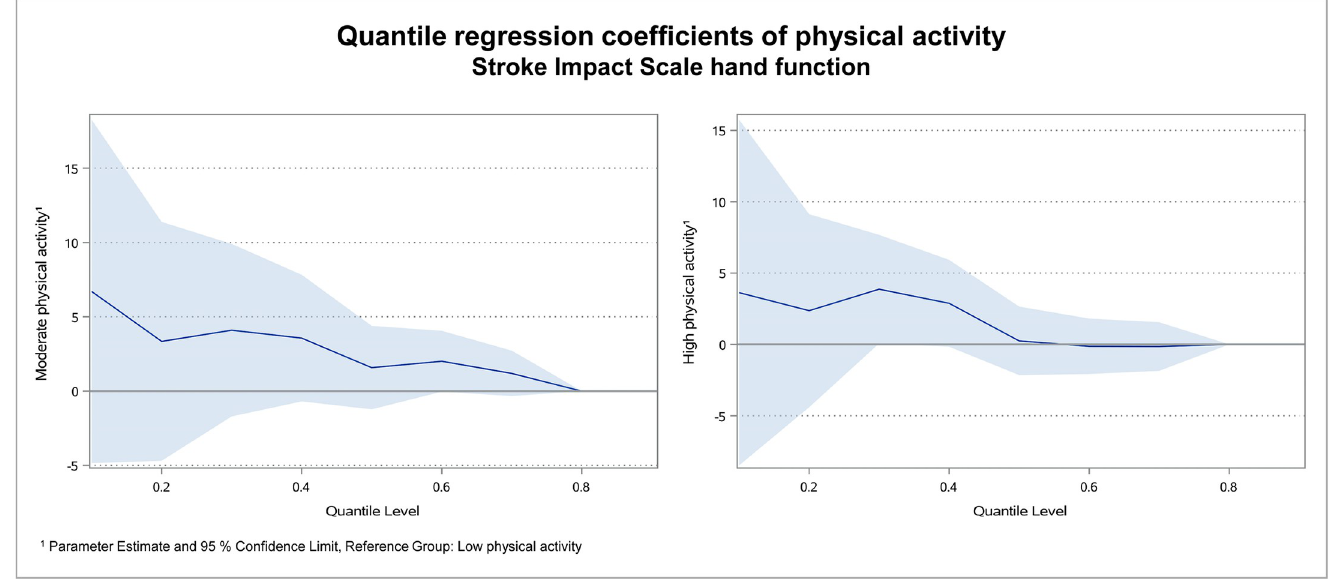
Fig 3. Quantile regression coefficients of physical activity for SIS hand function. In the subdomain hand function, the coefficient of moderate was 6.7 in quantile 0.1 and 1.2 in quantile 0.7. For high physical activity the coefficient was 3.6 in quantile 0.1 and -0.2 in quantile 0.7. Due to the high number of SIS hand function scores of 100, the maximum score of 100 was reached in quantile 0.7 and the quantile regression coefficients could not be calculated for quantiles 0.8 and 0.9.